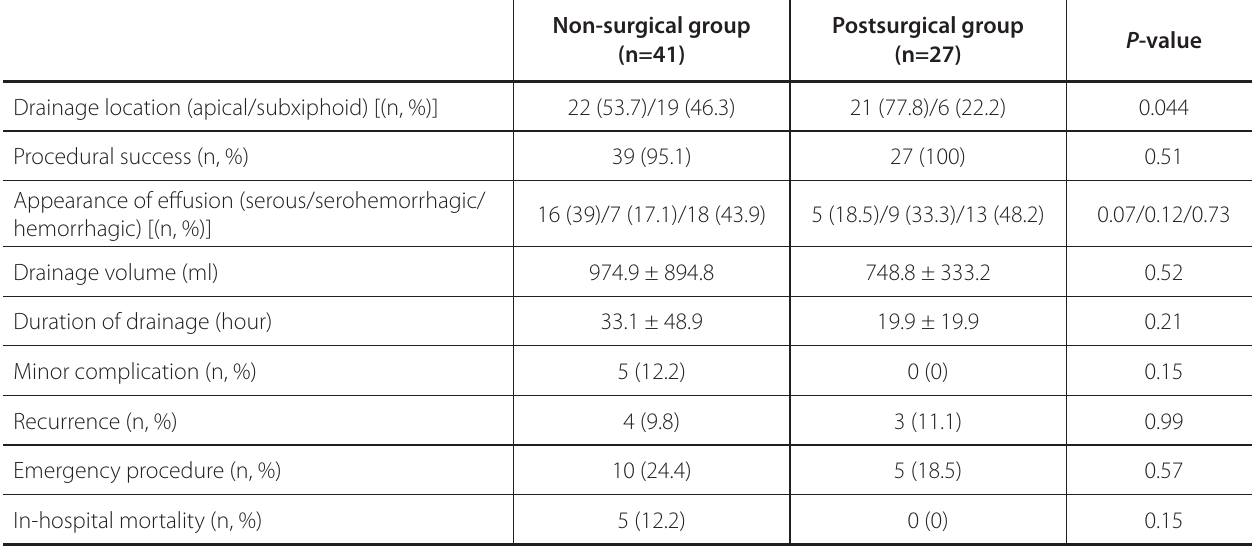
Table 2 . Procedural